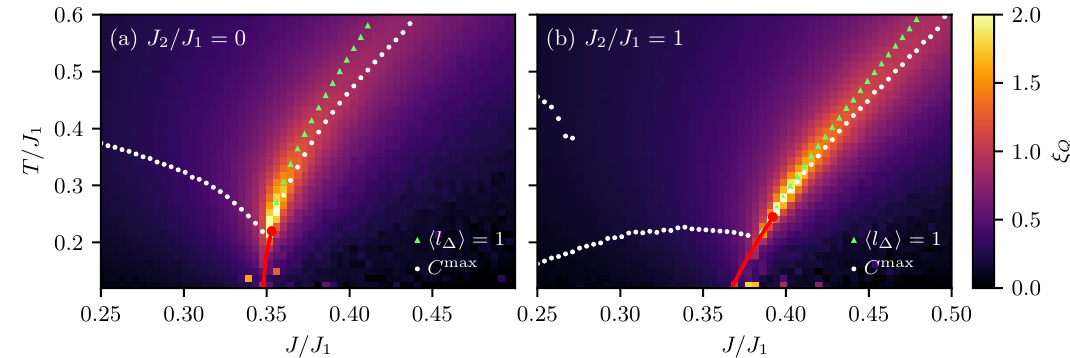
Figure 9: Quartet correlation length, ξ L = 12 FFTL model at (a) a representative non-degenerate intra-trimer coupling, / J = 0, and (b) the degenerate point, J J 2 1 constant- J maxima in the specific heat, T max , and the “critical isochore” line where 〈 l 〉 = 1. In both panels, the critical point and the approximate first-order line are ∆ shown in